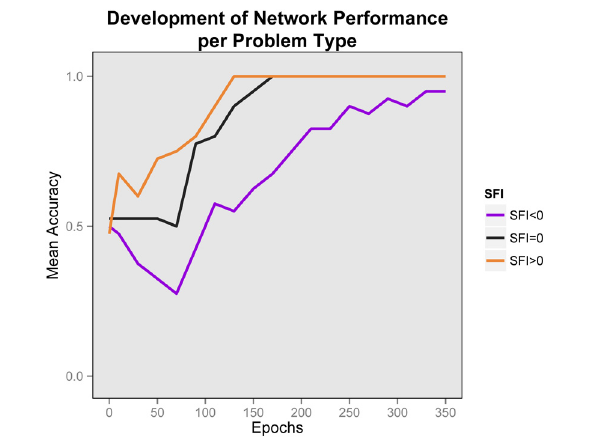
FIGURE 5 | Development of performance by problem type. Average performance of networks, by problem type in time. The relational shift is apparent by the early bifurcation of the plotted lines according to problem type combined with the convergence to correct responses later. Chance is at 0 . 5. Early in training, performance is below chance for the negative SFI problems and higher SFI problems are learned faster. Later, performance is improved for all problem